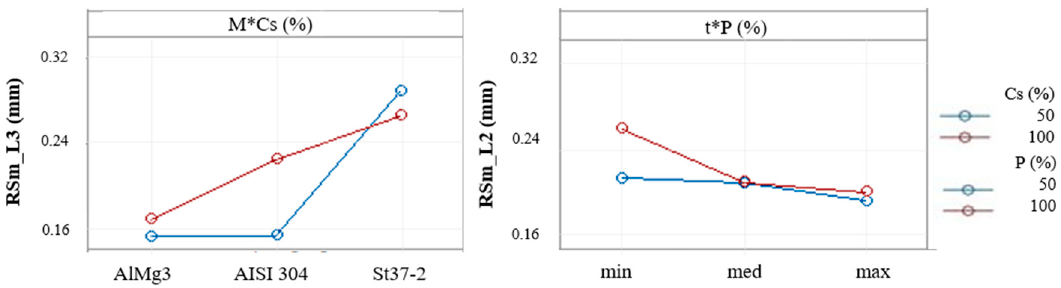
Figure 15. Main effects plot for mean width of profile elements (upper, middle and lower workpiece surface).